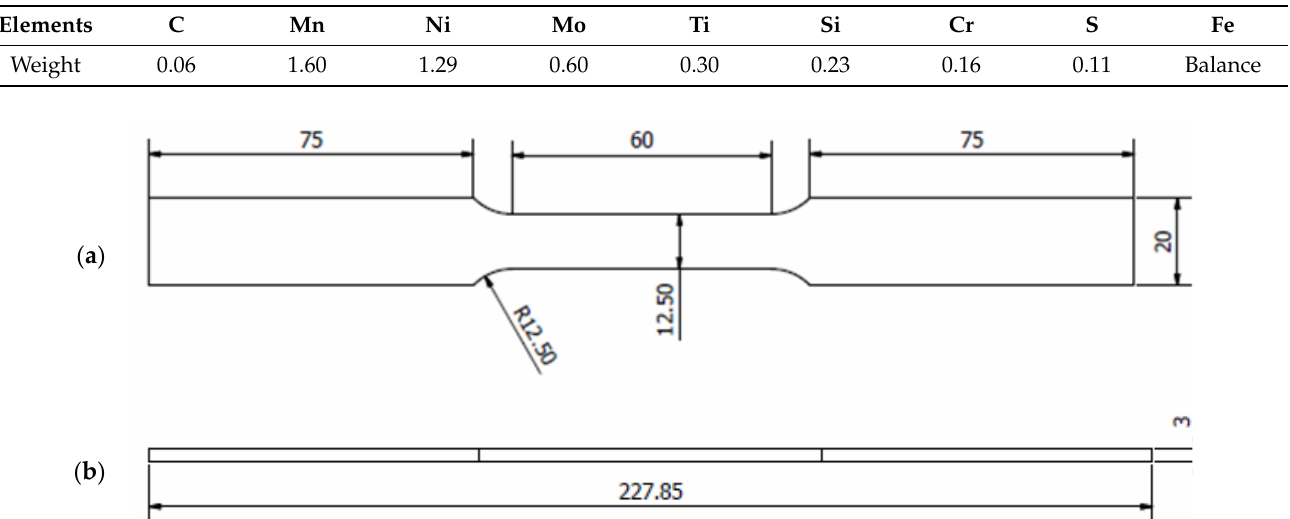
Figure 2. Details of the geometry of the API steel X65 specimens (unit in mm); ( a ) upper geometry schematic and ( b ) side geometry schematic.